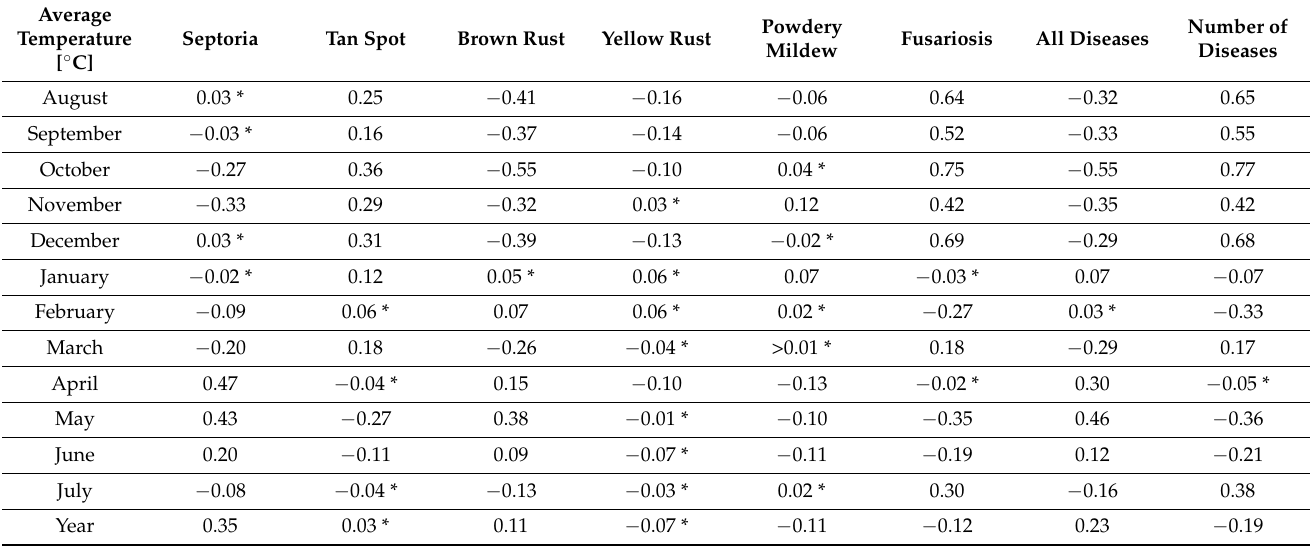
Table 2. Pearson’s linear correlation between average air temperature and wheat foliar disease